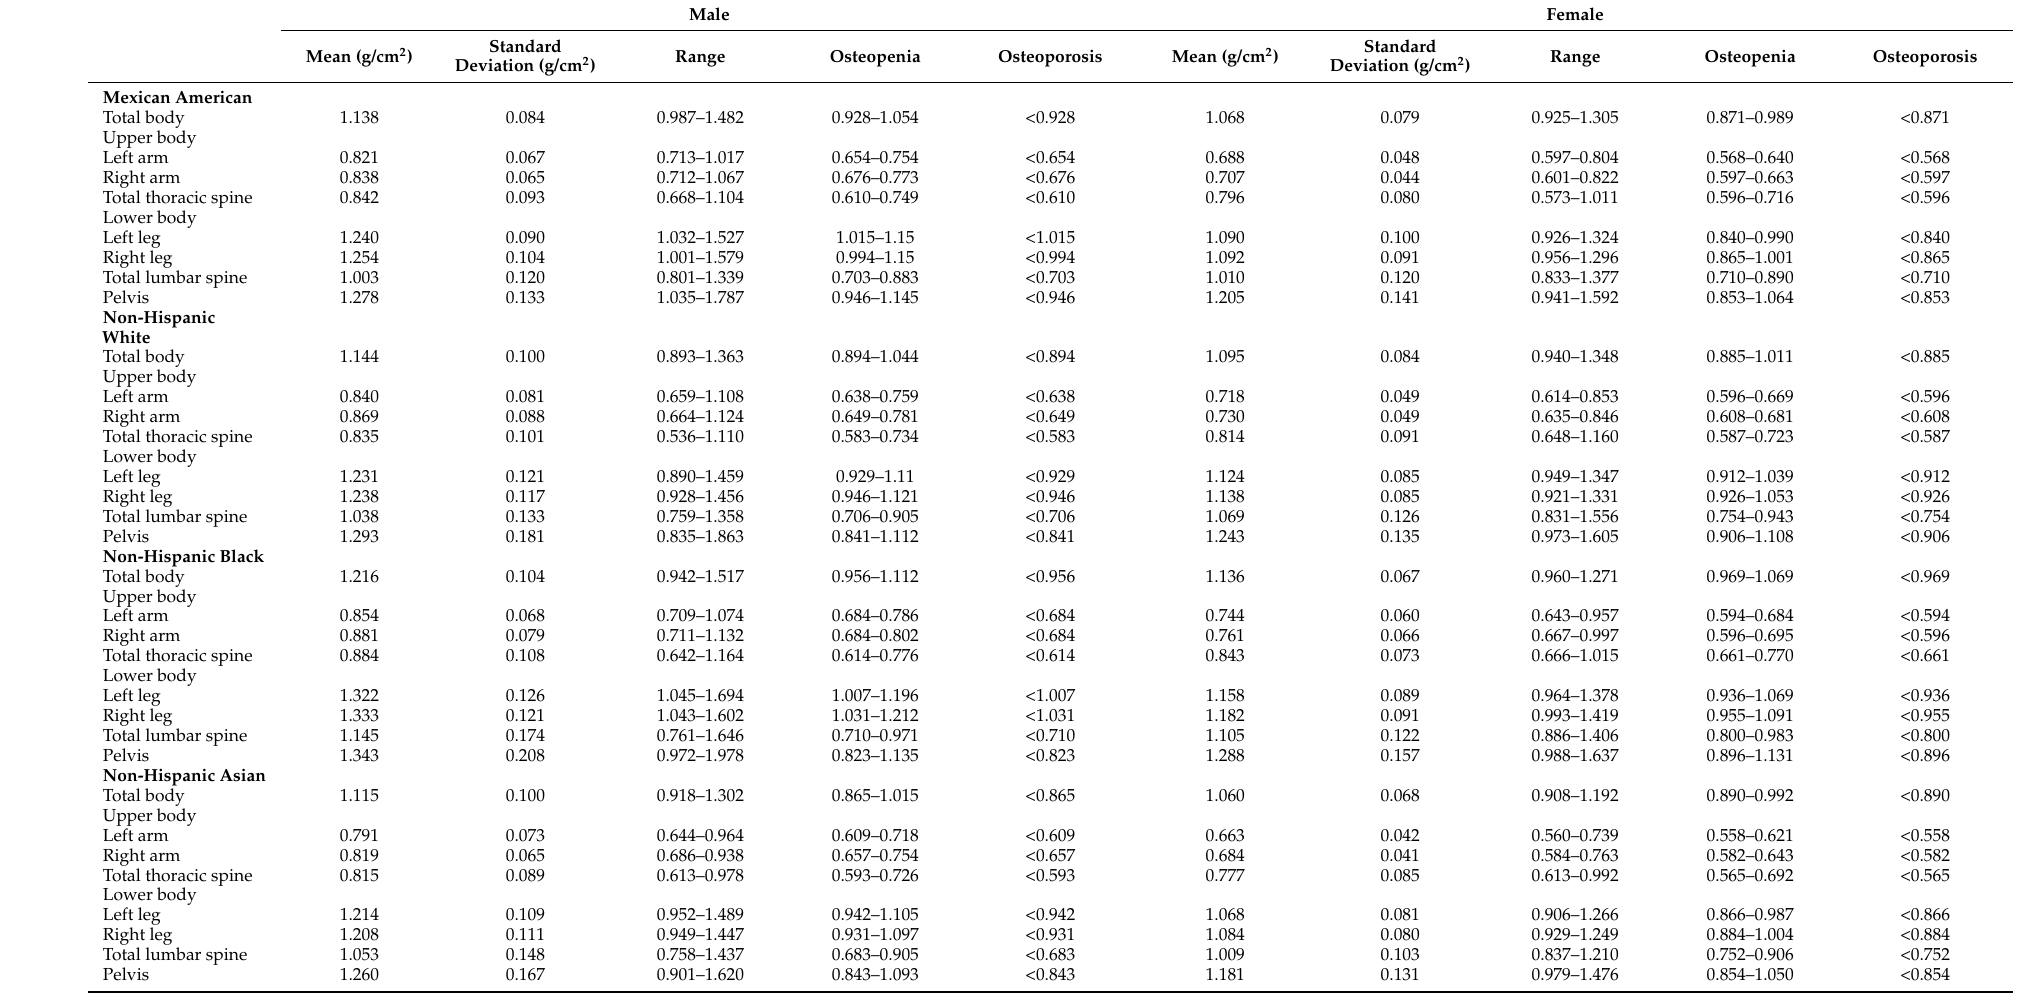
Table 2. Mean bone mineral density of osteopenia and osteoporosis aged 20–29 years in